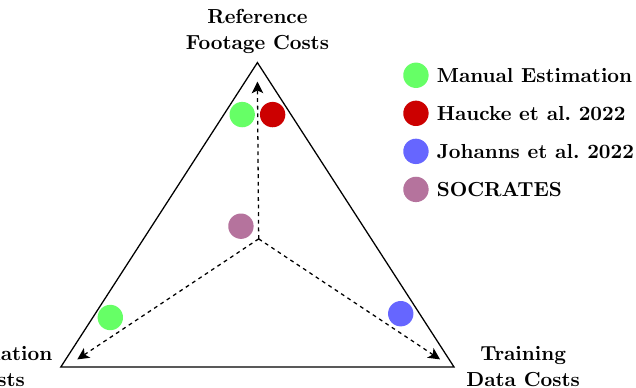
Figure 8. Tradeoff between reference footage costs, manual distance estimation costs, and training data costs. The manual approach requires both the acquisition of reference footage and labor- intensive manual animal distance estimation. Reference [25] requires reference footage, but the distance estimation itself is automated. Reference [26] requires neither reference footage nor manual distance estimations, but requires training data of similar scenes. SOCRATES measures distance using stereo vision and, therefore, incurs none of these costs.